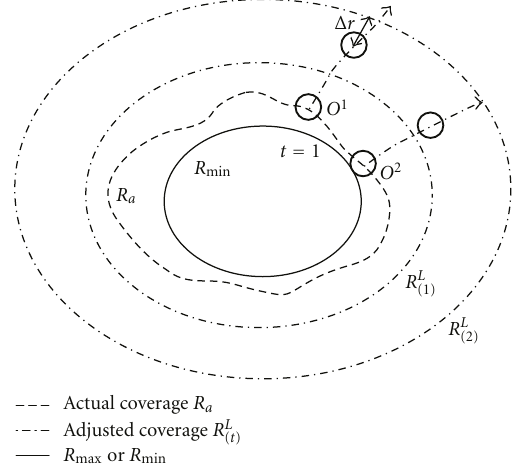
Figure 9: Illustration of coverage enlargement when objects leave the coverage of an identification